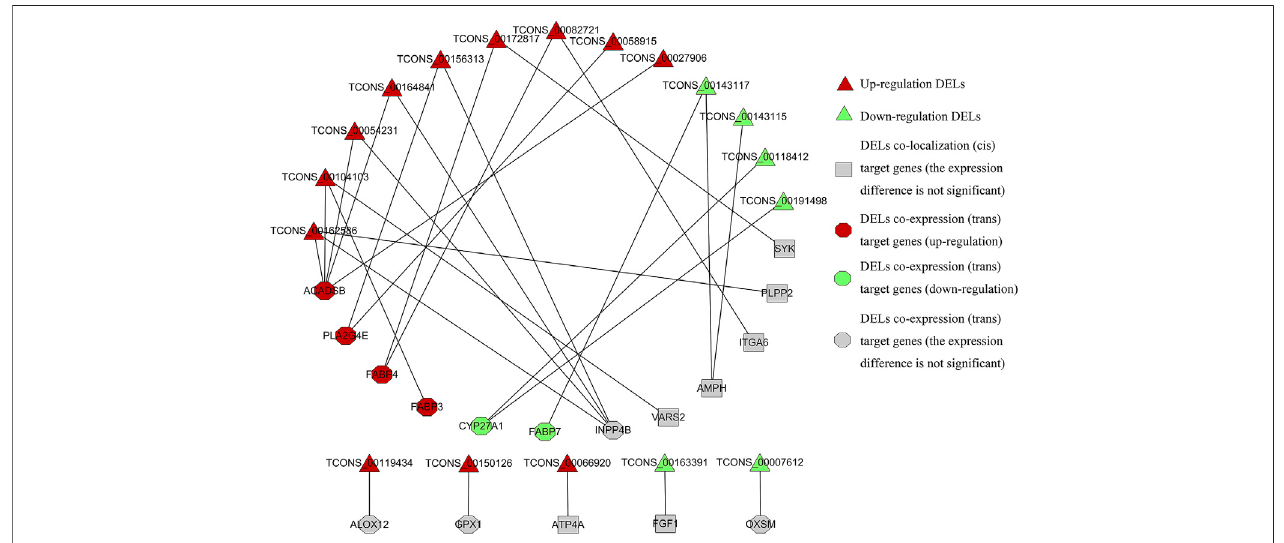
FIGURE 8 | Regulatory relationship between DELs and target genes related to lipid